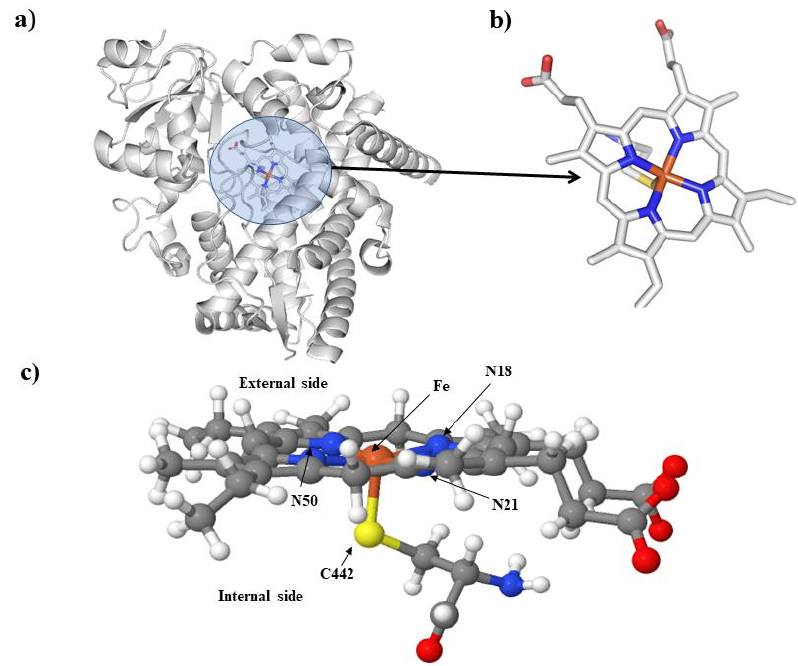
Figure 3. ( a ) Structure of CYP 3A4 obtained by homology of crystal 4KW9, ( b ) heme group’s atoms, Fe nucleus, and the amino acid C442, all extracted from the structure of CYP 3A4, and ( c ) again, the heme group with Fe and C442.